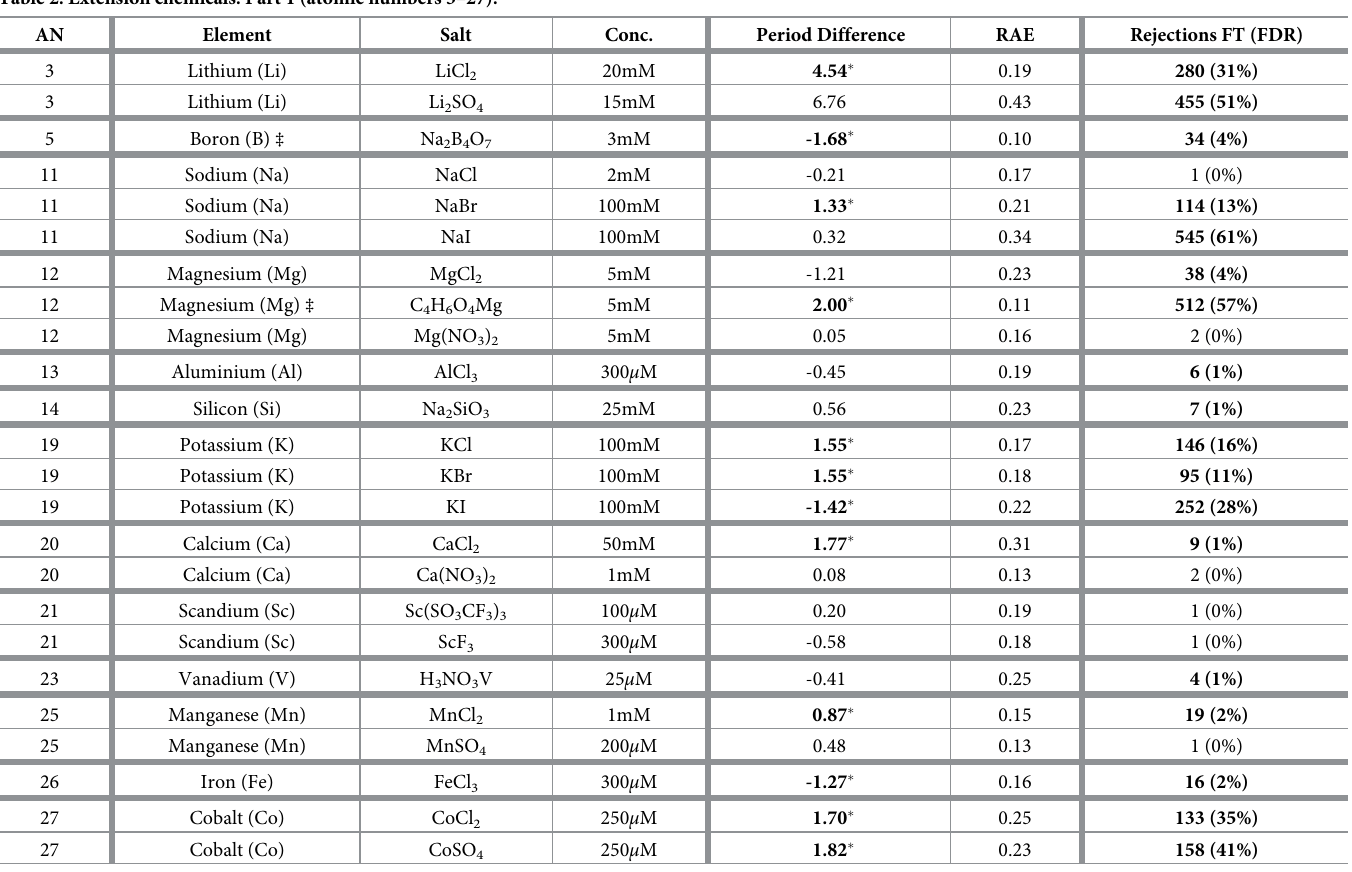
Table 2. Extension chemicals: Part 1 (atomic numbers